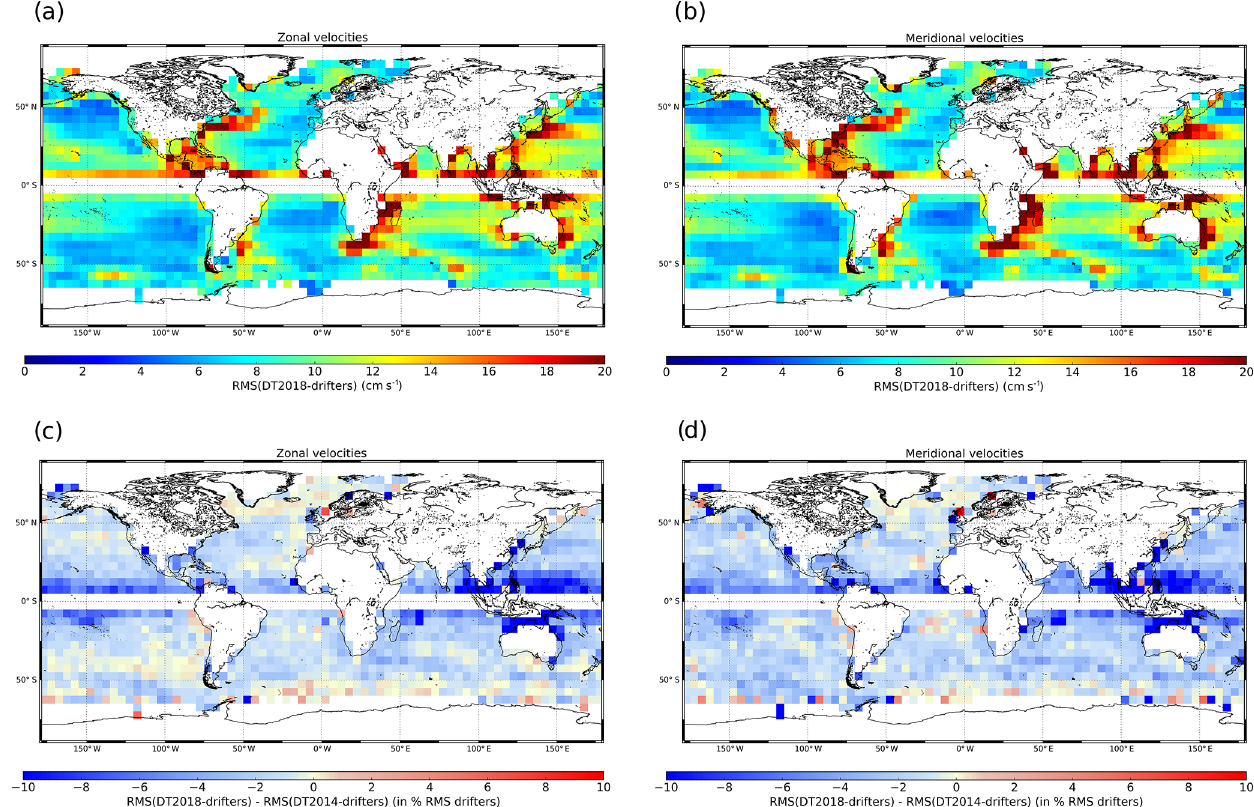
Figure 6. Zonal (a) and meridional (b) RMS of the difference between DUACS DT2018 absolute geostrophic current and drifter measure- ments over the 1993–2017 period. Zonal (c) and meridional (d) difference of the RMS of the altimeter geostrophic currents minus drifters measurements successively using the DT2018 and DT2014 gridded products. Negative values represent reduced differences between DT2018 altimetry products and drifters. The statistic is expressed as a percentage of the RMS of drifter measurements. Statistics have been computed in boxes of 5 ◦ × 5 ◦ . Boxes with fewer than 1000 points have been